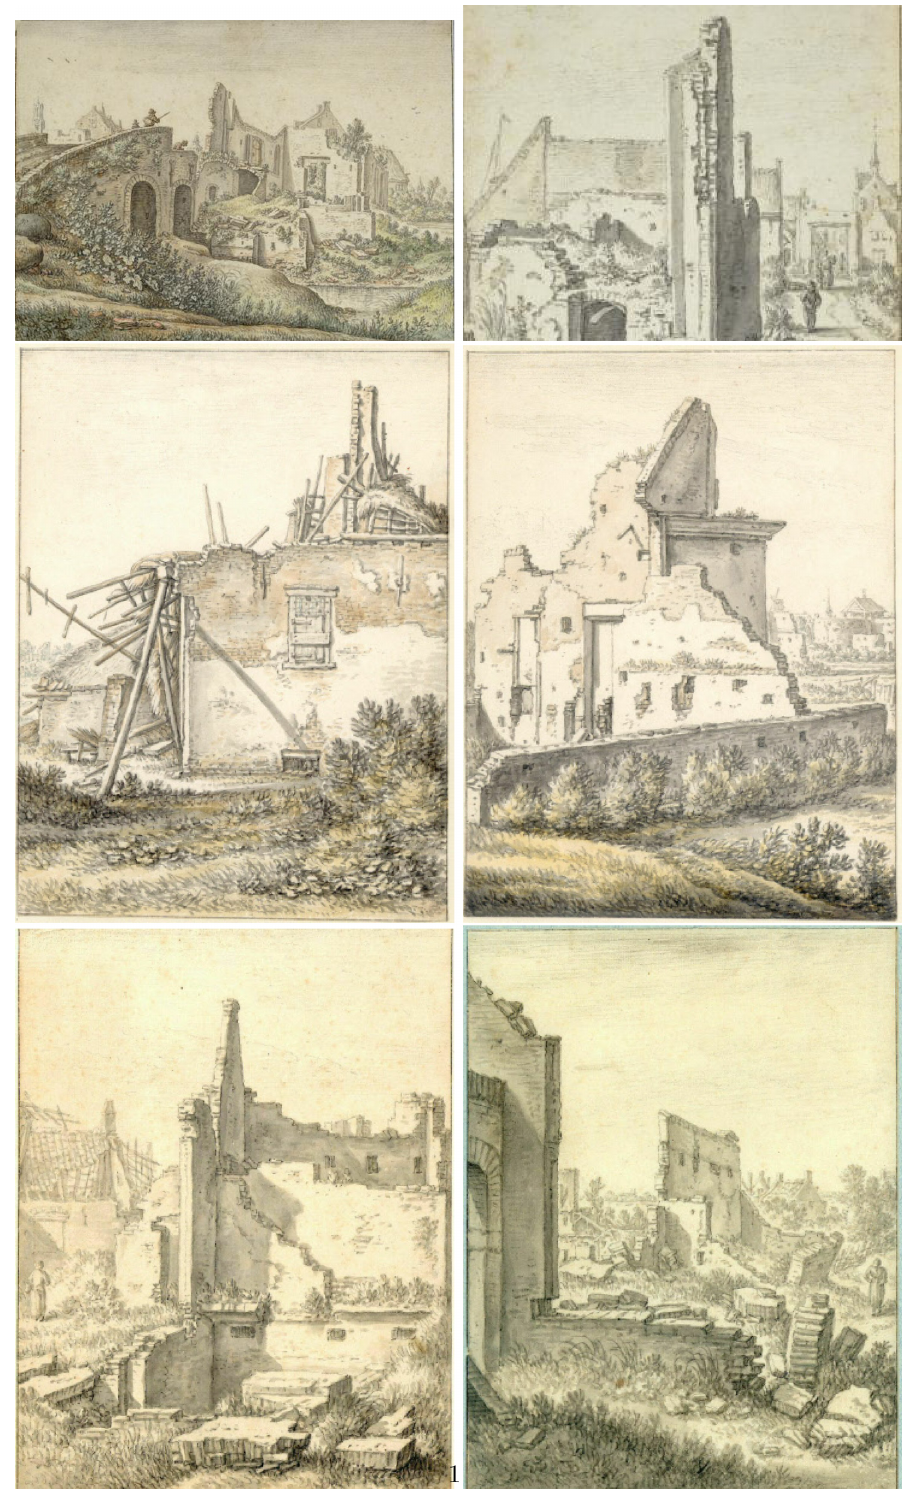
Figure 7. Selection of drawings of Herman Saftleven following the storm of 1674. (a) View on Gildbridge near the Biltsche Grift (30817), (b) ruined house at the “Nieuwe Weerd” (38525), (c) farm Abstede (26155), (d) outside the Catharijne gateway (38638), (e) just outside Wittevrouwen (38526), and (f) ruin of St Bethlehem, just outside the Catharijne gateway (37718). Numbers in parentheses refer to the Utrecht City Archive catalogue